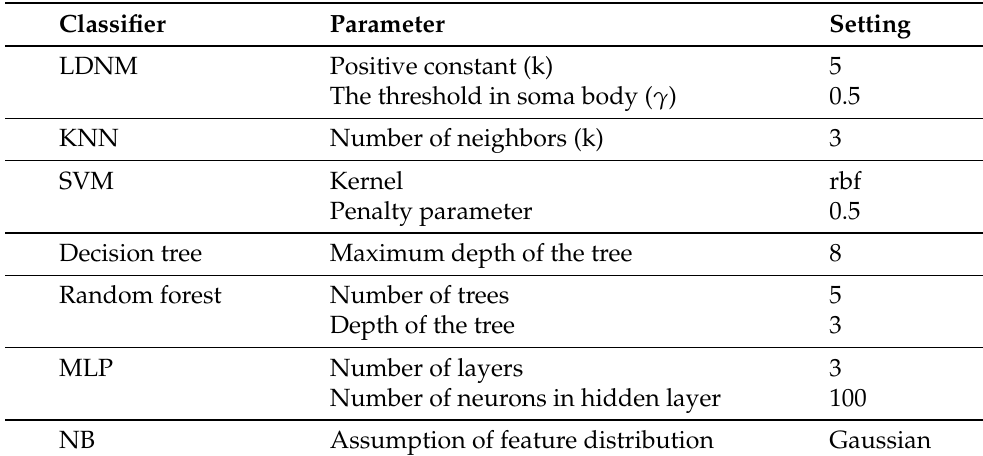
Table 4. Parameter settings for seven classifiers.